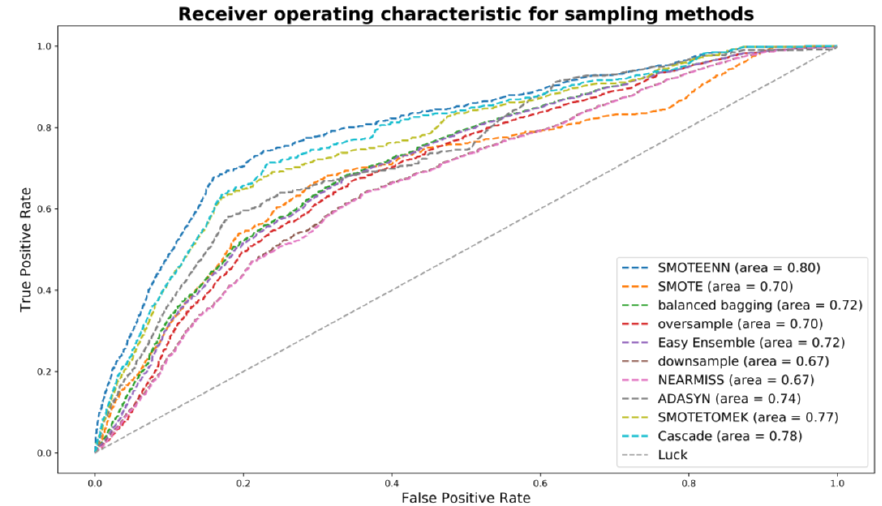
Figure 3. Receiver operating characteristic (ROC) curves of all sampling methods for 2016–2017 periods (scenario 3).